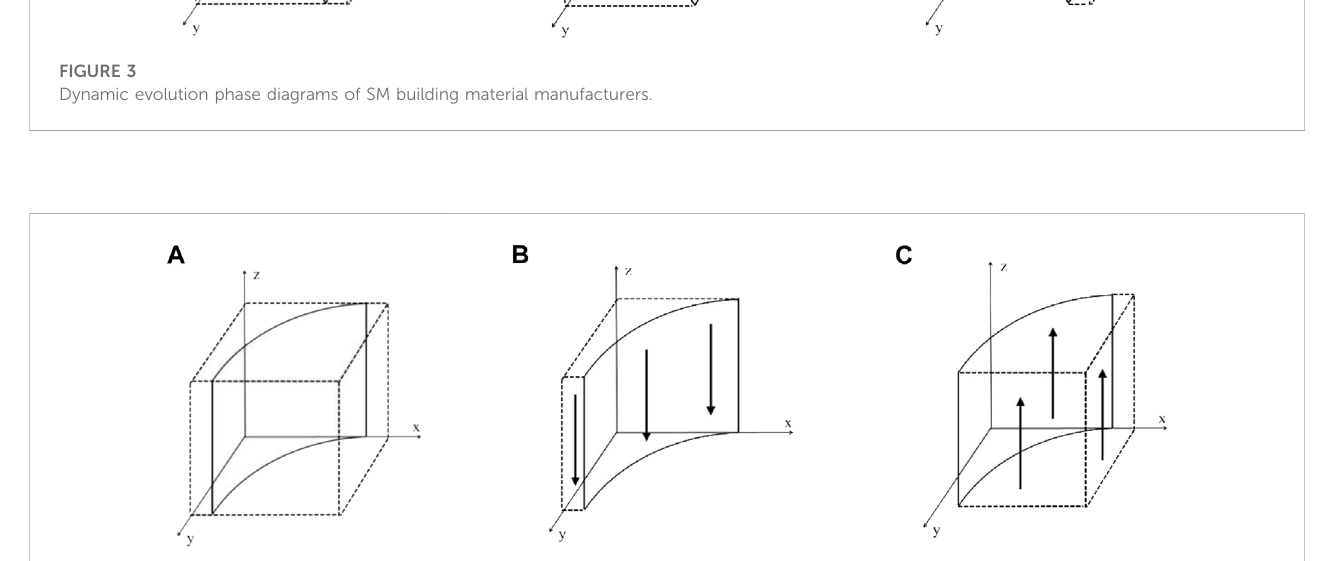
FIGURE 4 Dynamic evolution phase diagrams of research